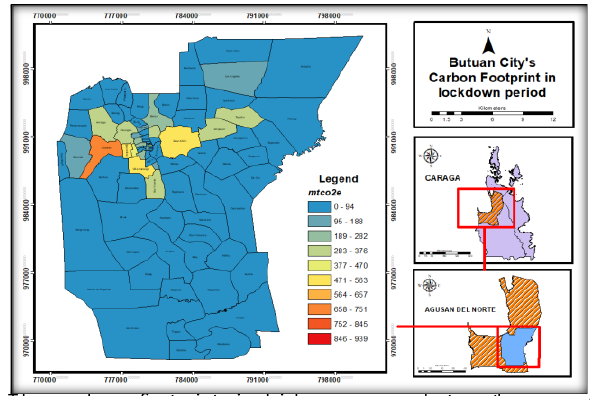
Figure 7. Spatial distribution of carbon footprint